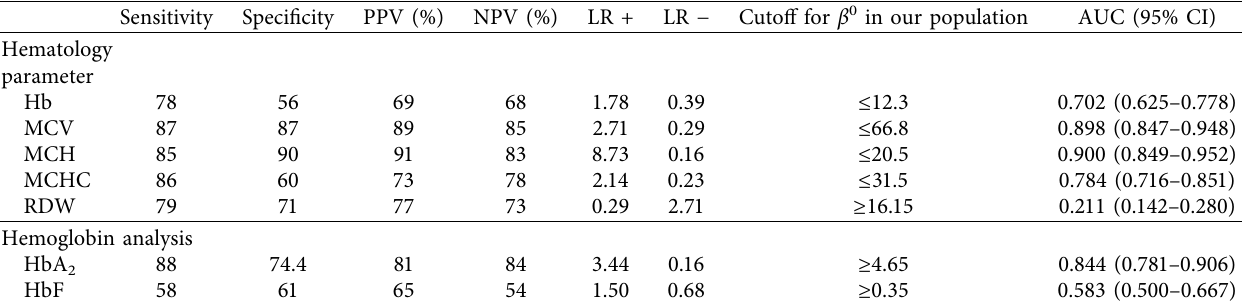
Table 5: Evaluation of different hematological parameters and Hb analysis in the differentiation of β 0 -thalassemia compared to β +-thalassemia.